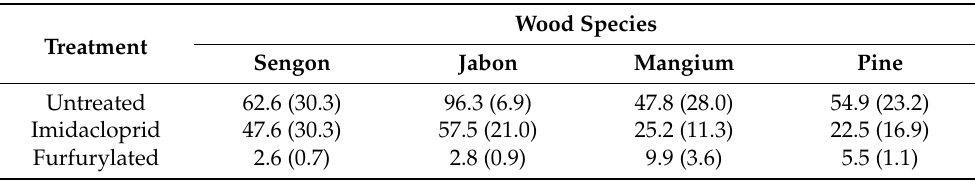
Table 10. Weight loss percentage of wood specimens.